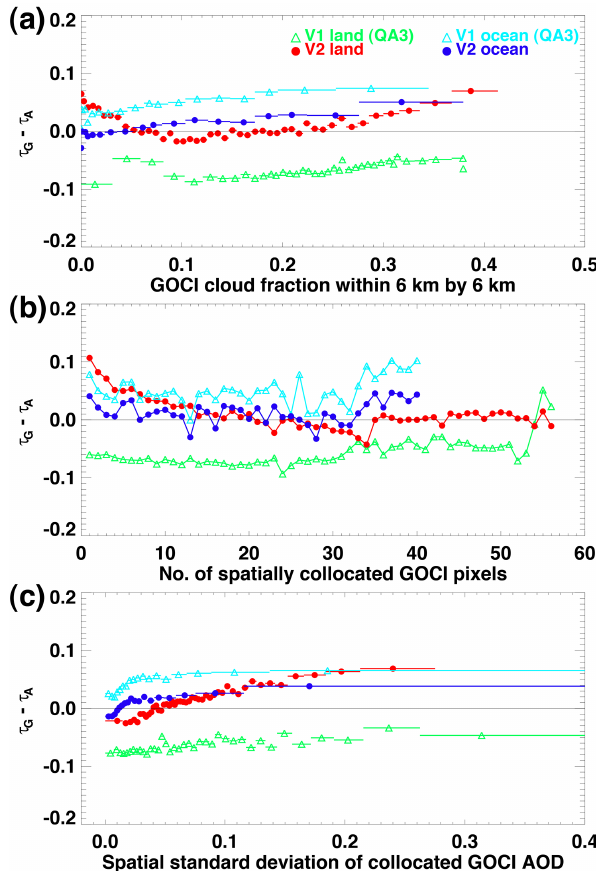
Figure 7. Difference between GOCI and AERONET AOD in terms of (a) GOCI cloud fraction within each aerosol product pixel (6km × 6km), (b) the number of spatially collocated GOCI pix- els within a 25km distance from AERONET sites, and (c) the spa- tial standard deviation of collocated GOCI AOD. The points, dotted lines, and horizontal lines in (a, c) are as defined in Fig.